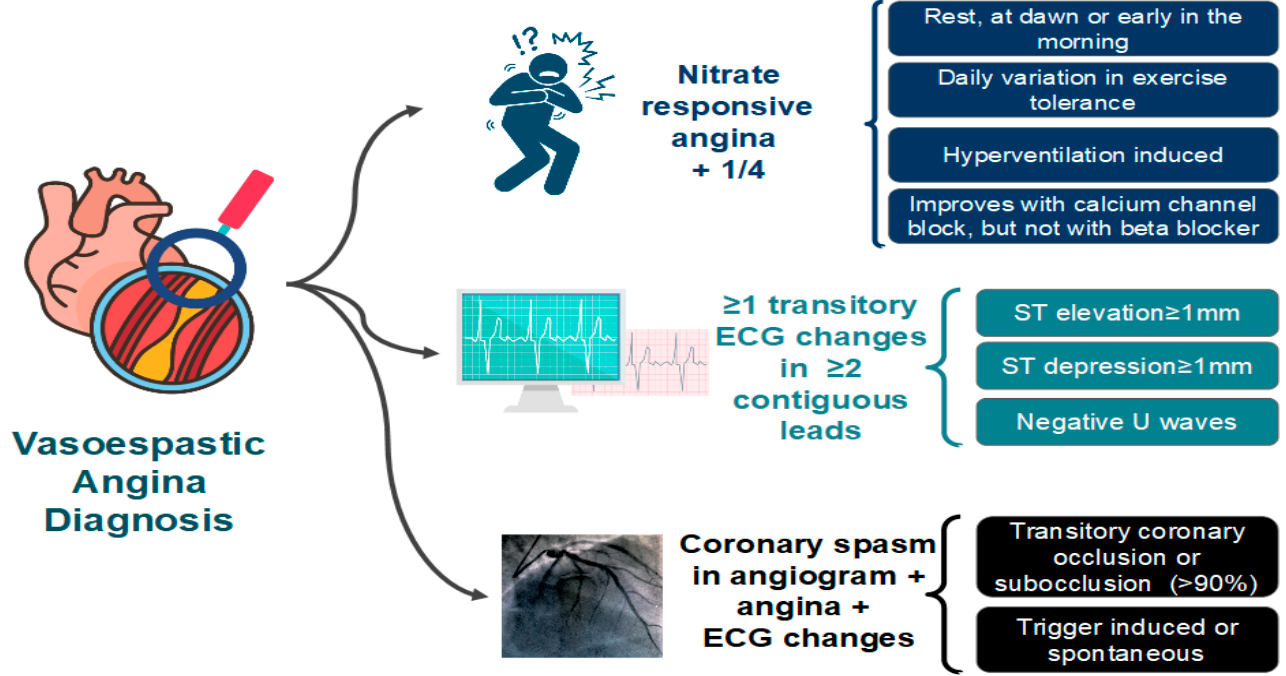
Figure 6. Diagnostic criteria for vasospastic angina (VSA) proposed by the Coronary Vasomotion Disorders International Study Group (COVADIS). ECG: electrocardiogram [64].